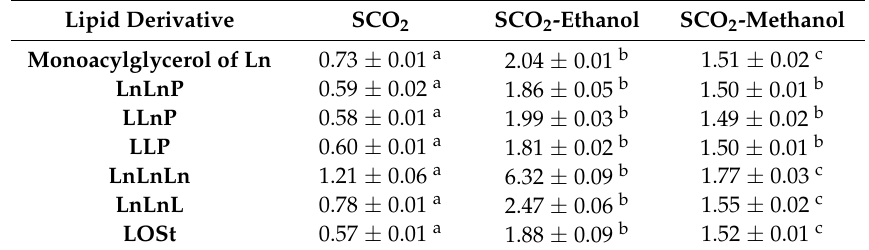
Table 6. Lipids composition (mg/g) of the extracts obtained by SCO 2 with methanol or ethanol as